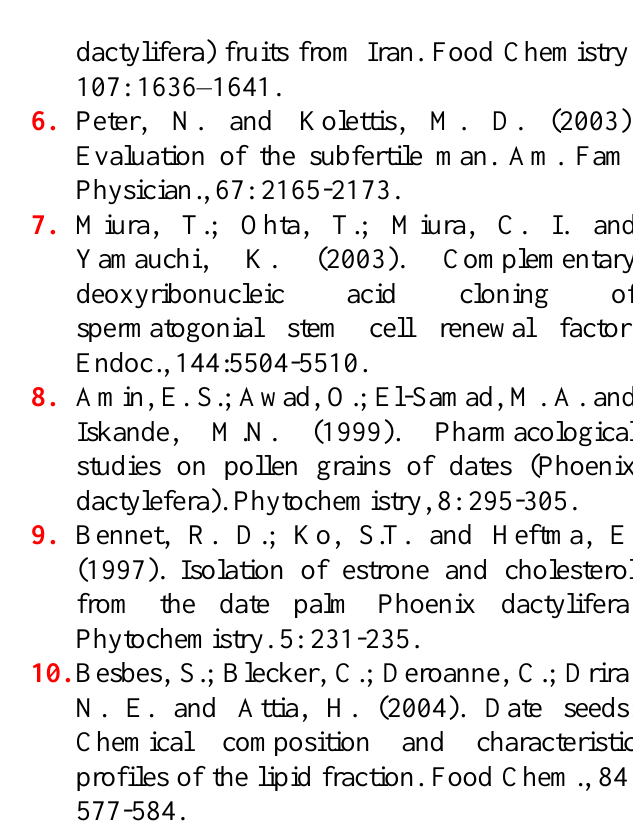
Different letters refer to significant (p<0.05) differences compared between